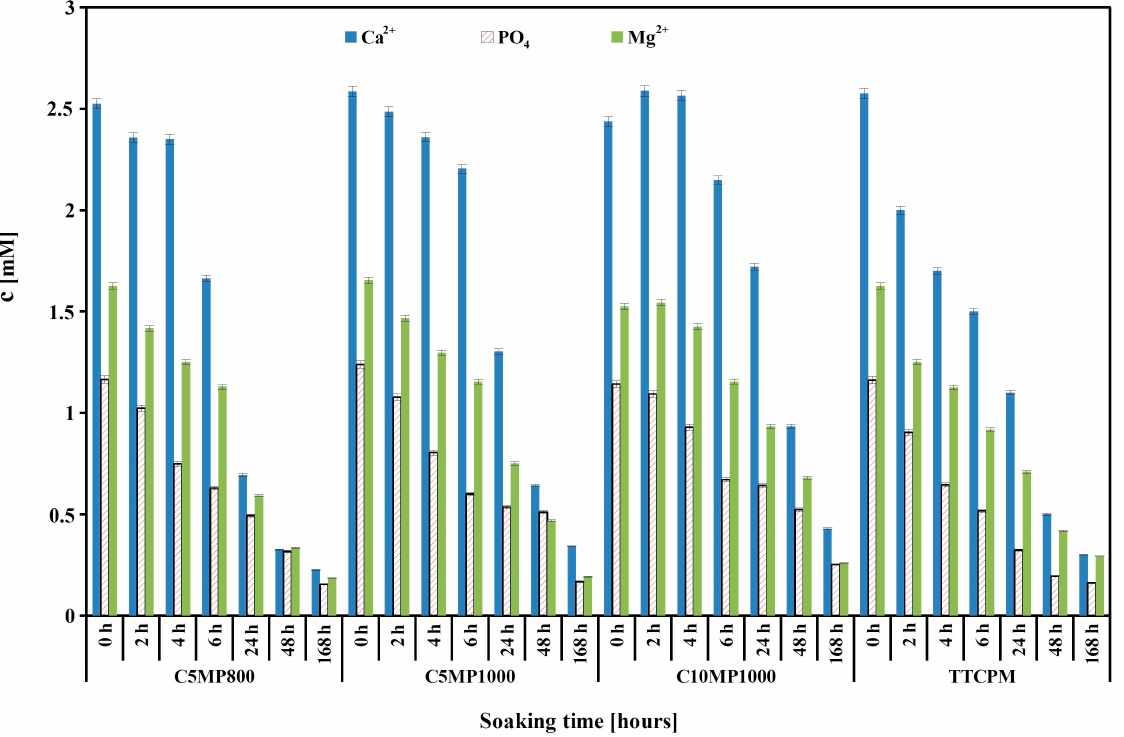
Figure 1. Release of calcium, magnesium, and phosphate ions during soaking of C1MP850, C1MP1000, C2MP1000, and TTCPM samples in SBF at 37 °C.